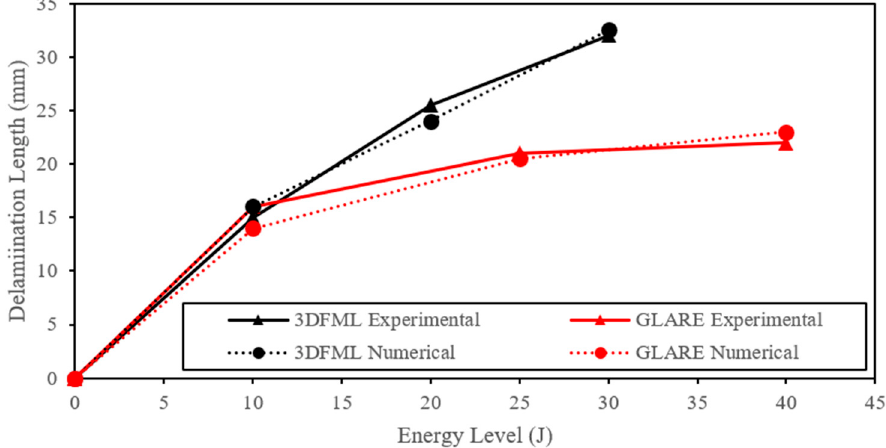
Figure 13. Comparison of the experimentally measured and numerically predicted delamination lengths as a function of applied impact energy.